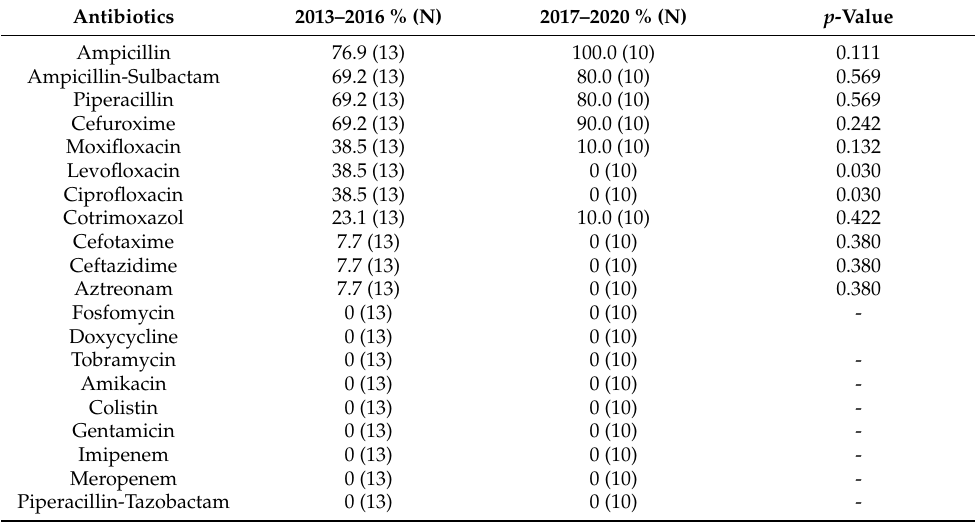
Table 5. Trends in antibiotic resistance of Escherichia coli isolates from neonatal sepsis